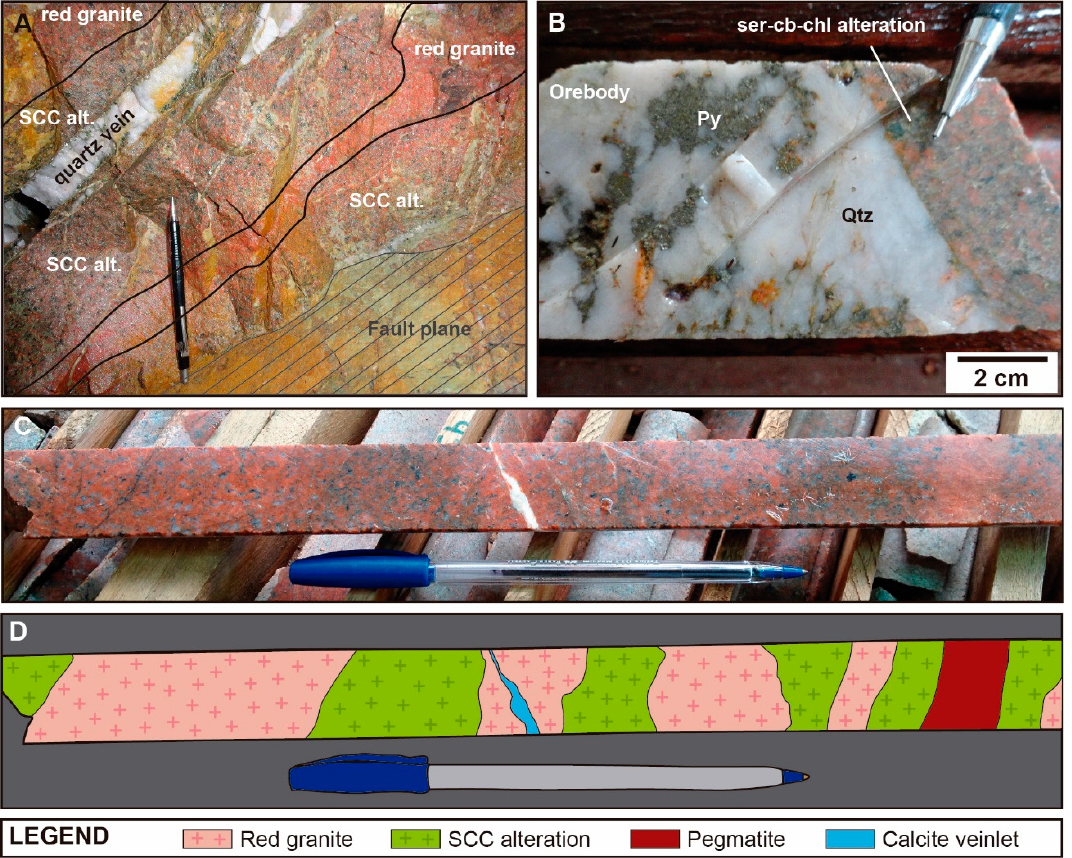
Figure 9. Sericite–carbonate–chlorite (SCC) alteration in the Passa Três deposit: ( A ) Zebra pattern formed by the alternation of greenish granite (SCC alteration) and red granite near orebody; ( B ) SCC alteration along the border of a quartz–sulphide vein (borehole sample); ( C , D ) Drill core sample exhibiting zebra-pattern ( C ) and its schematic drawing ( D ). Abbreviations: Py—pyrite; Qtz—quartz.